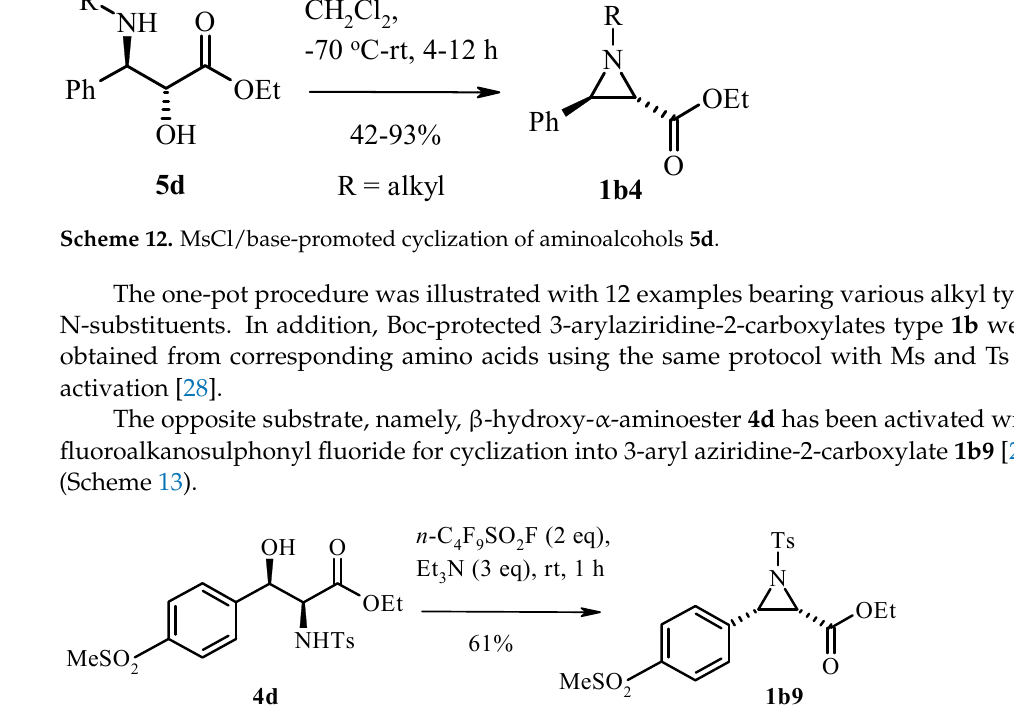
MeSO 2 Scheme 13. Fluoroalkanosulphonyl fluoride-promoted cyclization of ester 4d . Scheme 13. Fluoroalkanosulphonyl fluoride-promoted cyclization of ester 4d Scheme 13. Fluoroalkanosulphonyl fluoride-promoted cyclization of ester 4d .